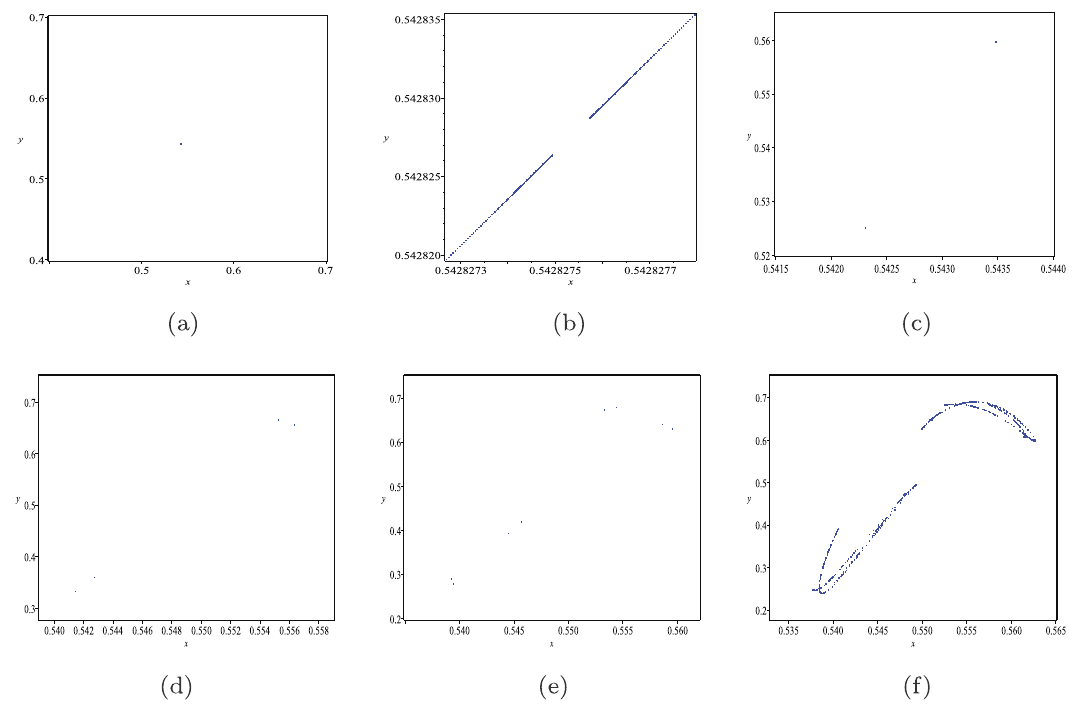
Figure 4: Phase portraits for various values of δ corresponding to Figure 3. ( a ) δ 0.9 = , ( b ) δ 1.03 = , ( c ) δ 1.037 = , ( d ) δ 1.26 = , ( e ) δ 1.31 = , and ( f ) δ 1.35 =